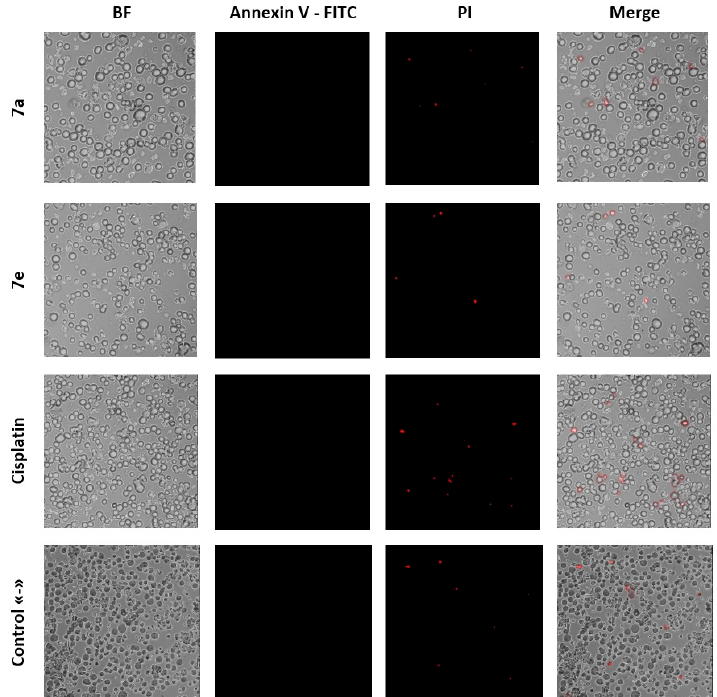
Figure 5. Fluorescence staining of human embryonic HEK-293 kidney cells with Annexin V-FITC and PI dyes under the action of the test compounds 7a and 7e in comparison with cisplatin (concentration of 6 μ M) and intact cells. Cells in early apoptosis were stained green (Annexin V- FITC), cells in late apoptosis and necrosis were stained red (PI), 200× magnification. Measurement of the cell’s ability to synthesize DNA is one of the most important methods for evaluating cell proliferative activity, determining toxicity, and evaluating antitumor drugs. The EdU (5-ethyl-2’-deoxyuridine) assay is a nucleoside analog of thymidine and is incorporated into DNA during active DNA synthesis. The detection is based on a copper-catalyzed covalent reaction between azide and alkyne, which are contained in the dye and EdU, respectively. Assessing the effect of compounds 7a and 7e under study on the ability of cells to synthesize DNA in the HEK-293 line (Figure 6), a minimal effect comparable to intact cells, which served as a negative control, can be noted. Some decrease in proliferative activity can be noted in cisplatin-treated cells. At the same time, a more pronounced effect of compounds 7a and 7e on DNA synthesis in cells is observed in line A-172 (Figure 7). It should also be noted that no signs of cell proliferation were detected in the experiment with compound 7e . In addition, Figures 4 and 7 show a significant decrease in the total number of cells in the experiment with compound 7e relative to the other groups. Thus, the results obtained indicate the activation of apoptotic mechanisms and the inhibition of proliferation in glioblastoma cells under the influence of compound 7e . Taken together, this may indicate a pronounced selective antitumor effect of compound 7e .